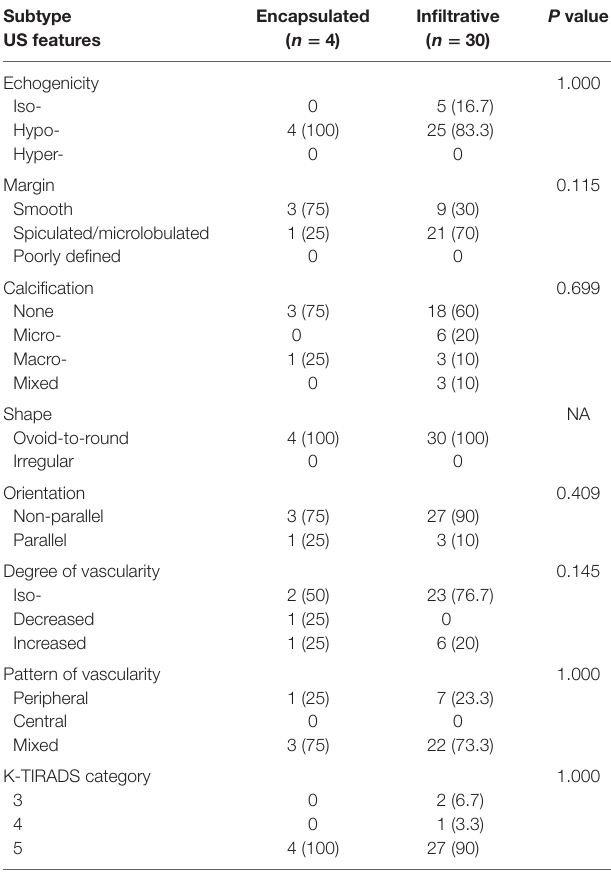
TaBle 2 | Ultrasonographic features of encapsulated and infiltrative follicular variants of